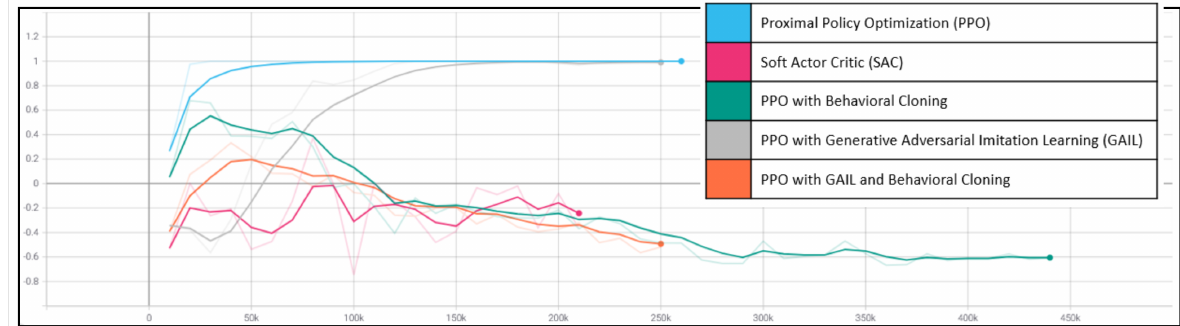
Figure 17. Simulation runs vs. cumulative